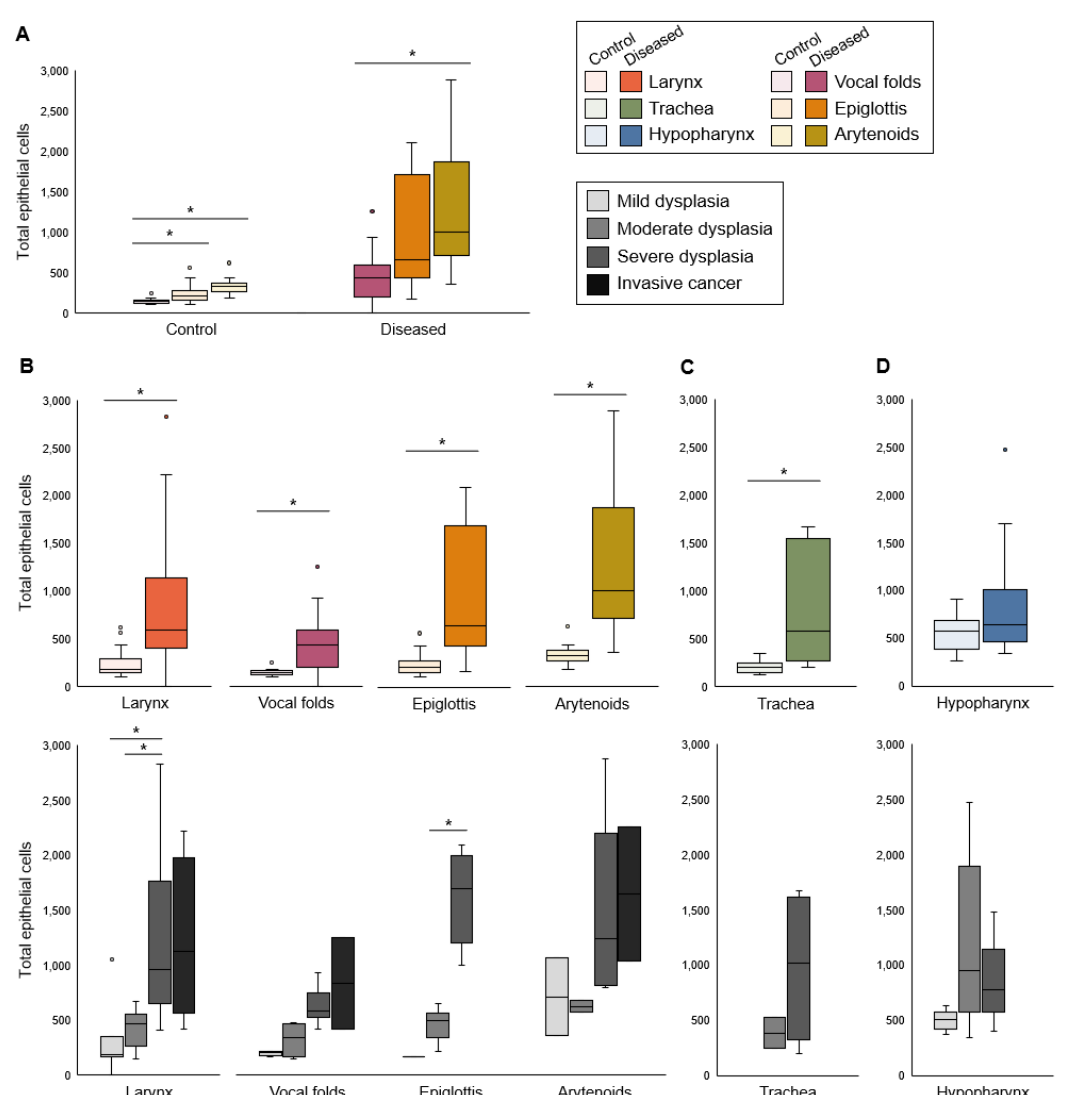
Figure 1. Total epithelial cells increased in diseased larynx and trachea. ( A ) Difference among laryngeal tissues in cell counts, n = 12–16 mice per tissue type in each condition. Kruskal–Wallis tests: control p < 0.0001, diseased p = 0.0034. *Significant post hoc DSCF pairwise tests: control vocal folds vs. epiglottis p = 0.0191, control vocal folds vs. arytenoids p < 0.0001, diseased vocal folds vs. arytenoids p = 0.0024. All other pairwise tests: p > 0.05. ( B ) Control vs. diseased laryngeal tissues and disease severity in laryngeal tissues. *Significant one-tailed Wilcoxon rank-sum tests for control vs. disease: larynx p < 0.0001, n = 41 mice per condition; vocal folds p < 0.0001, n = 16 mice per condition; epiglottis p = 0.0005, n = 13 mice per condition; arytenoids p < 0.0001, n = 12 mice per condition. Kruskal–Wallis tests for differences among severity levels: larynx p < 0.0001, n = 4–18 mice per disease stage; vocal folds p = 0.0240, n = 2–6 mice per disease stage; epiglottis p = 0.0079, n = 1–6 mice per disease stage; arytenoids p = 0.1979, n = 2–6 mice per disease stage. *Significant post hoc DSCF pairwise tests: mild vs. severe laryngeal dysplasia p = 0.0073, moderate vs. severe laryngeal dysplasia p = 0.0006, moderate vs. severe epiglottic dysplasia p = 0.0110. All other pairwise tests: p > 0.05. ( C ) Control vs. diseased trachea and disease severity in trachea. *Significant one-tailed Wilcoxon rank-sum test for control vs. disease: p = 0.0050, n = 8 mice per condition. Kruskal–Wallis test for differences among severity levels: p = 0.3173, n = 2–6 mice per disease stage. ( D ) Control vs. diseased hypopharynx and disease severity in hypopharynx. One-tailed Wilcoxon rank-sum test for control vs. disease: p = 0.1012, n = 17 mice per condition. Kruskal–Wallis test for differences among severity levels: p = 0.0862, n = 5–6 mice per disease